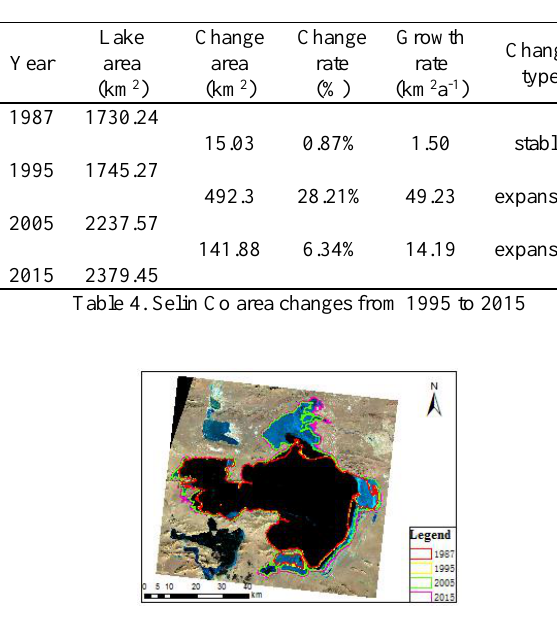
Figure 15. Selin Co area changes from 1995 to